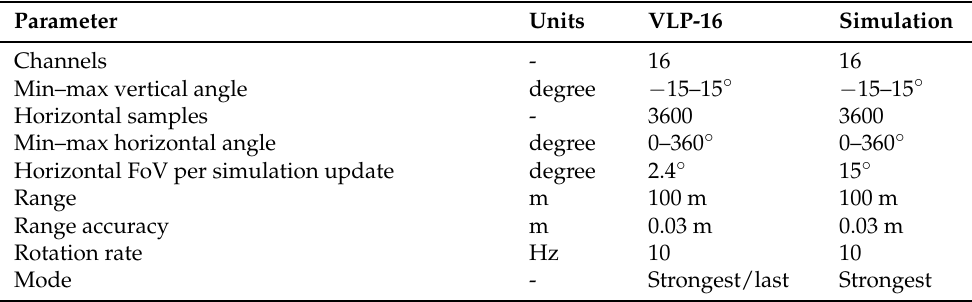
Table 1. The parameters of and actual and simulated Velodyne VLP-16 device. Parameter